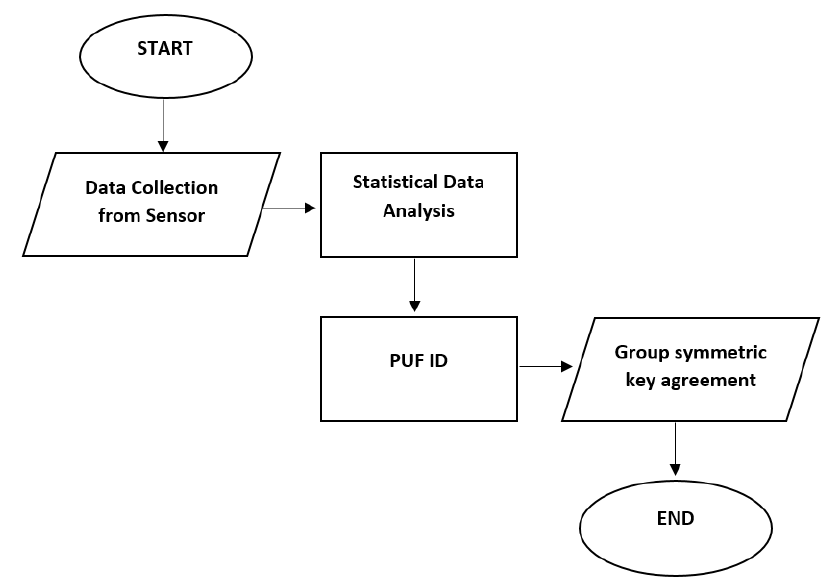
Figure 2. Flowchart showing individual